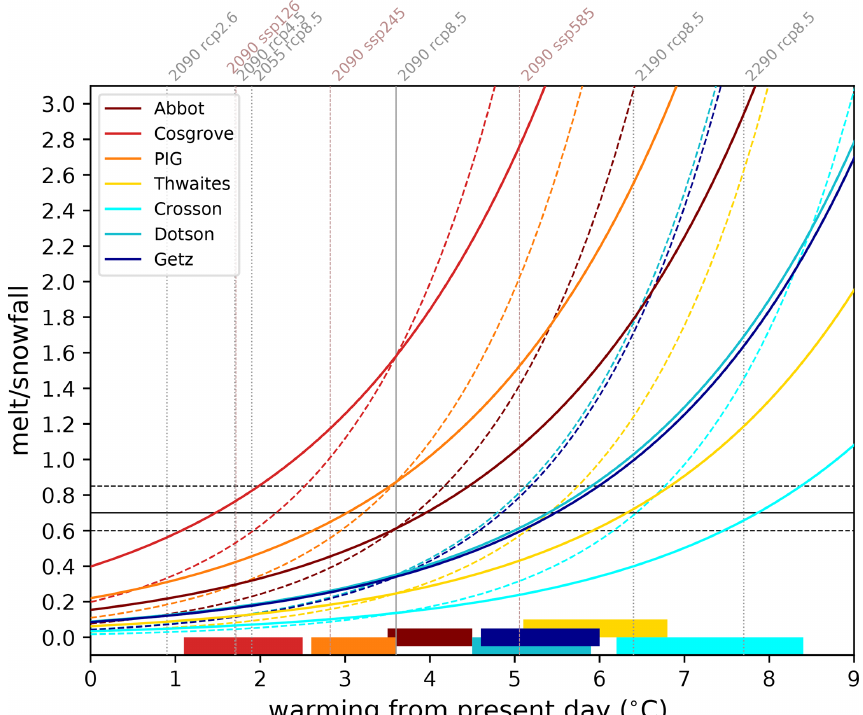
Figure 9. Extrapolated melt-to-snowfall ratio as a function of warming with respect to the present day (solid lines correspond to Eq. 2 and dashed lines to Eq. 3). The values obtained through our simulations correspond to the intersections with the vertical solid grey line. The vertical dashed grey lines represent warming at other dates (the dates indicated above the lines are the central years of 20-year averages) and under alternative scenarios (RCP2.6 and RCP4.5). This warming is derived from Collins et al. (2013) (their Table 12.2) assuming that the regional warming remains equal to global warming (supported by our results, as well as Collins et al., 2013). The corresponding warming for the CMIP6 multi-model mean (see list in Appendix A) under scenarios SSP126, SSP245, and SSP585 are indicated as vertical thin dashed rosy-brown lines. The horizontal black lines indicate three indicative thresholds for a net production of surface liquid water: the future 0.60 ratio simulated at Abbot in 2080–2100 (which is the minimum ratio for which we detect a significant production of surface liquid water), the 0.70 ratio estimated by Pfeffer et al. (1991), and the 0.85 ratio for which more than 50% of the grid points experience a net production of surface liquid water (Fig. 7). The warming range for which the extrapolations cross the 0.60 and 0.85 thresholds are indicated by the horizontal colour bars at the